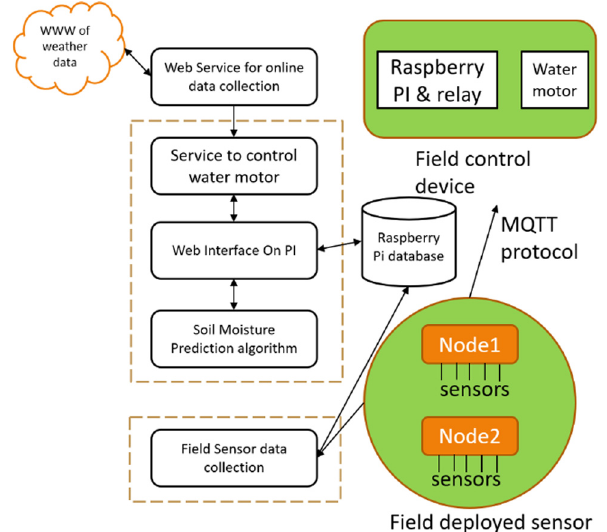
Figure 1: Architecture of the proposed